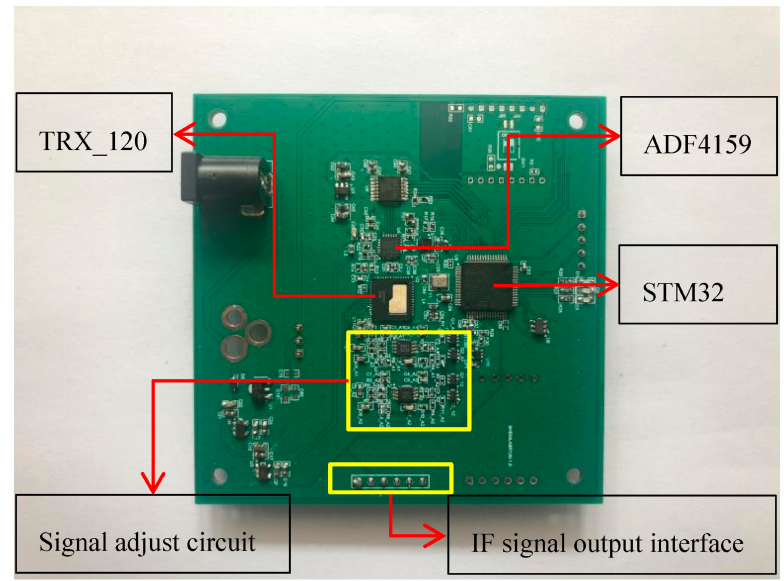
Figure 2. Picture of the 120 GHz radar sensor.